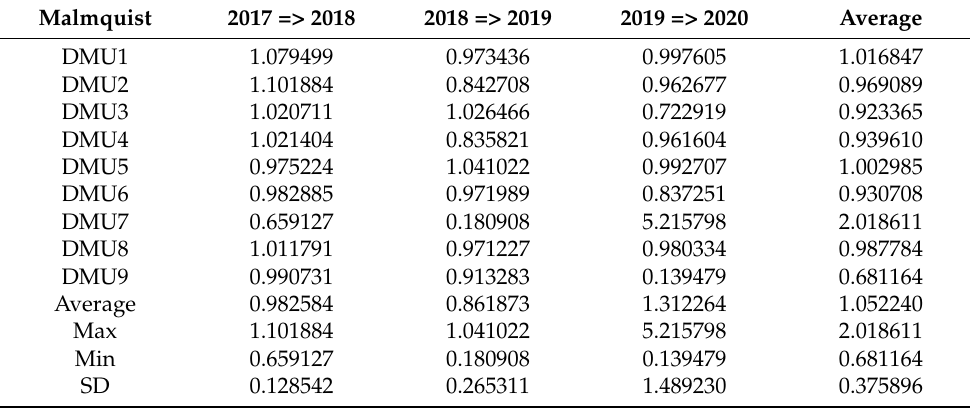
Table 5. Total factor productivity of DMUs from 2017 to